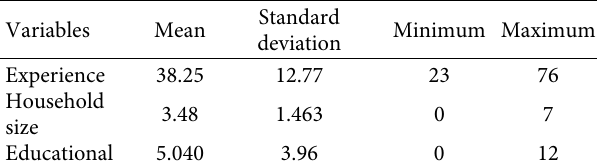
Table 2: Socio-economic feature of sample households.